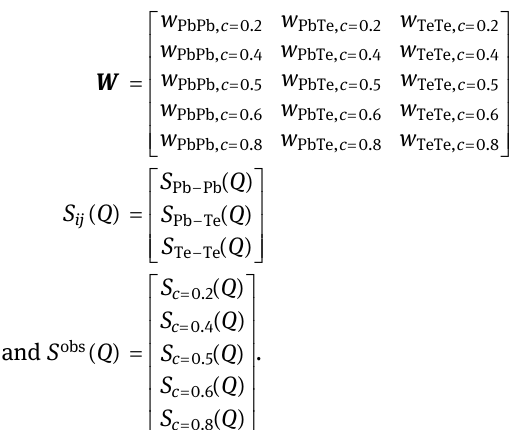
Figure 3: Estimated partial pair distribution functions, ( ) g r obtained from ( ) S Q ij ’